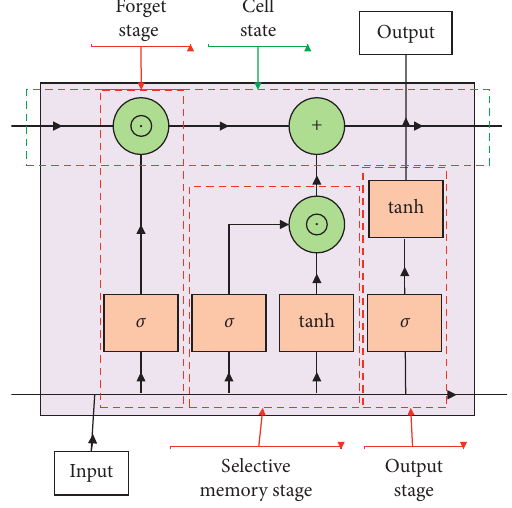
Figure 3: The unit of LSTM.